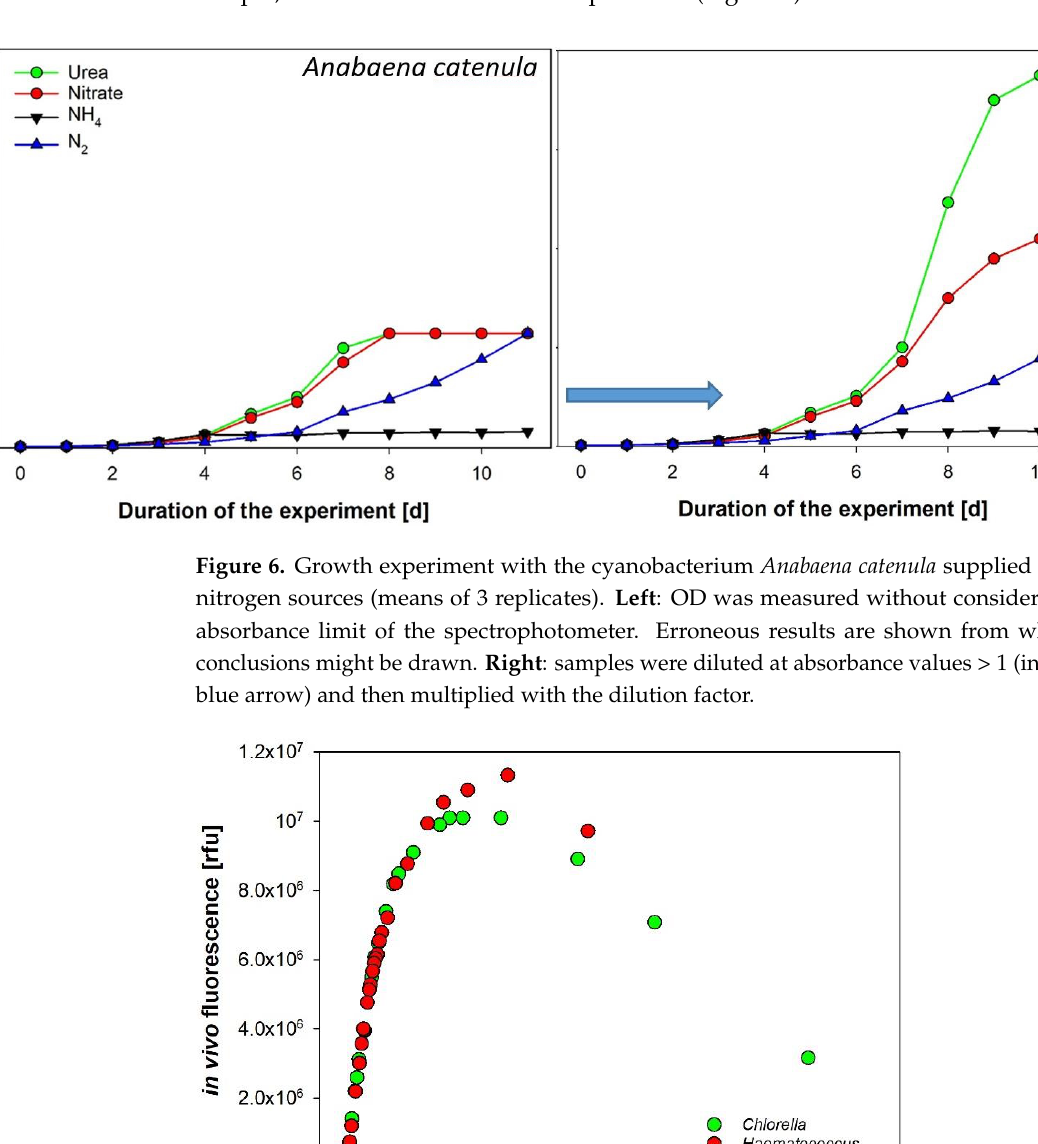
Figure 8. Growth of Chlorella vulgaris monitored by DM and in vivo chlorophyll autofluorescence (instrument SHIMADZU RF-5301PC). Samples with DM > 0.25 g L −1 (corresponds to OD ~ 0.5) were diluted with medium before measurements and the values multiplied by the dilution factor. All oxygenic photoautotrophs contain the natural fluorochrome chl-a. The pigment is widely used as a proxy for biomass of in situ measurements of phytoplankton [65,66] and sometimes also for algal cultivation [16], although a blurriness similar to that with the spectrophotometric method is evident. Interestingly, IVF turned out to be a better predic- tor for algal biomass than in vitro chl-a, which was explained by a stronger fluorescence signal of chl-a of live cells during adverse growth conditions [67]. As the fluorescence signal depends on the properties of the specimens being cultivated and also on the culture conditions, it must be calibrated separately for different cultures [63]. Independently of the device used, IVF revealed the same patterns during culture development. Besides sim- ple spectrofluorometers, an alternative is to use the minimum dark fluorescence F 0 of PAM-fluorescence devices for IVF as long as the instrument settings are not changed